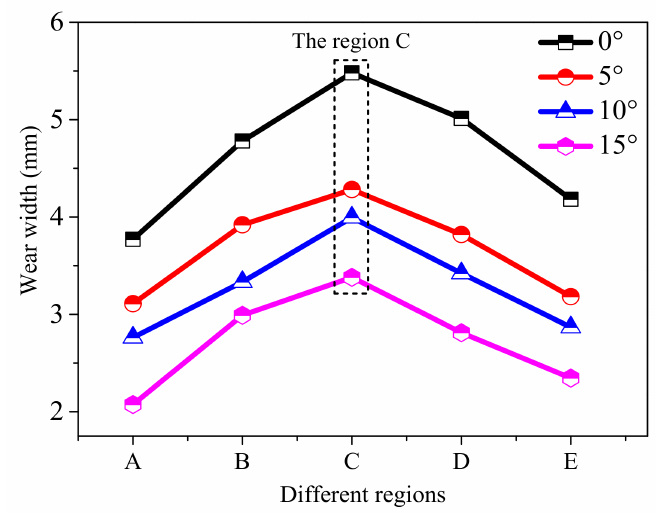
Figure 10. The changes of wear width with draft angle and wear region.